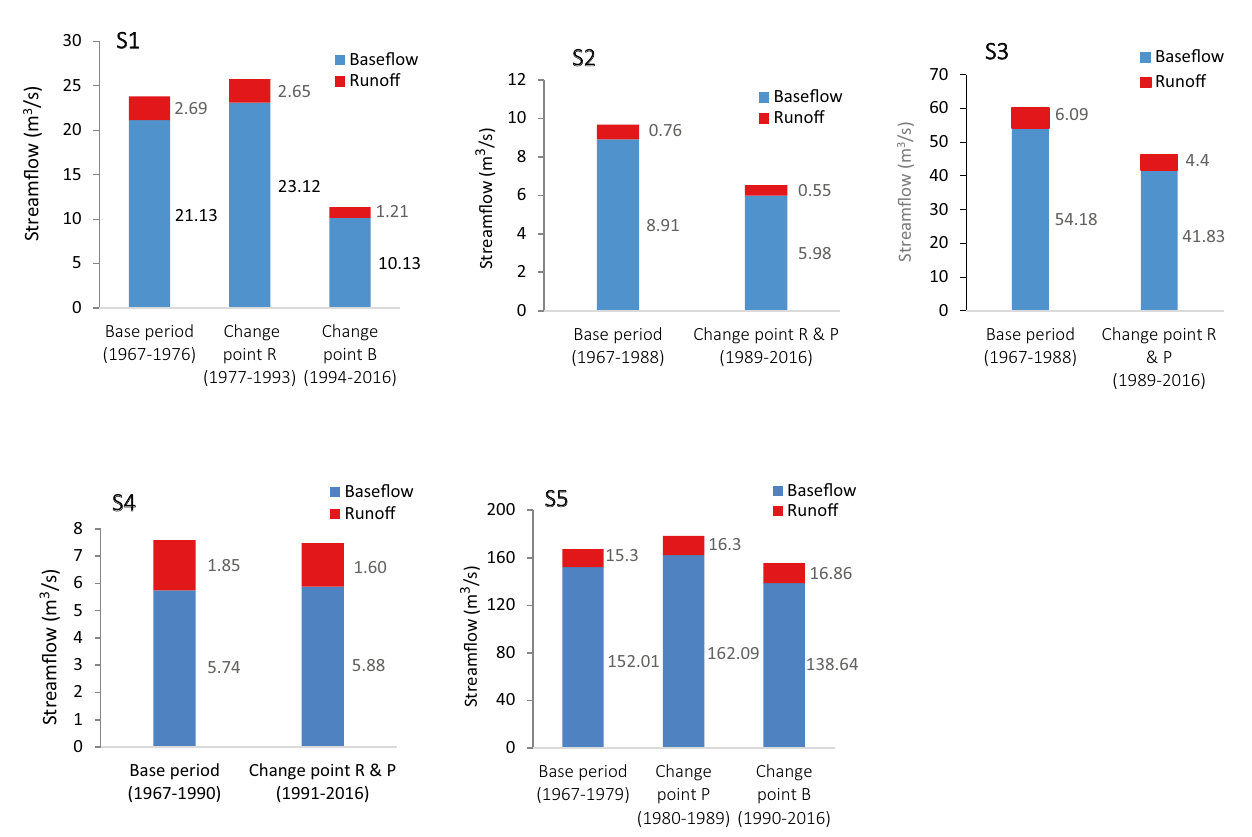
Figure 8. Baseflow and quick flow contributions in the streamflow after each change point in the P (precipitation), R (runoff), and B (BFI index) in the subbasins of the Dez